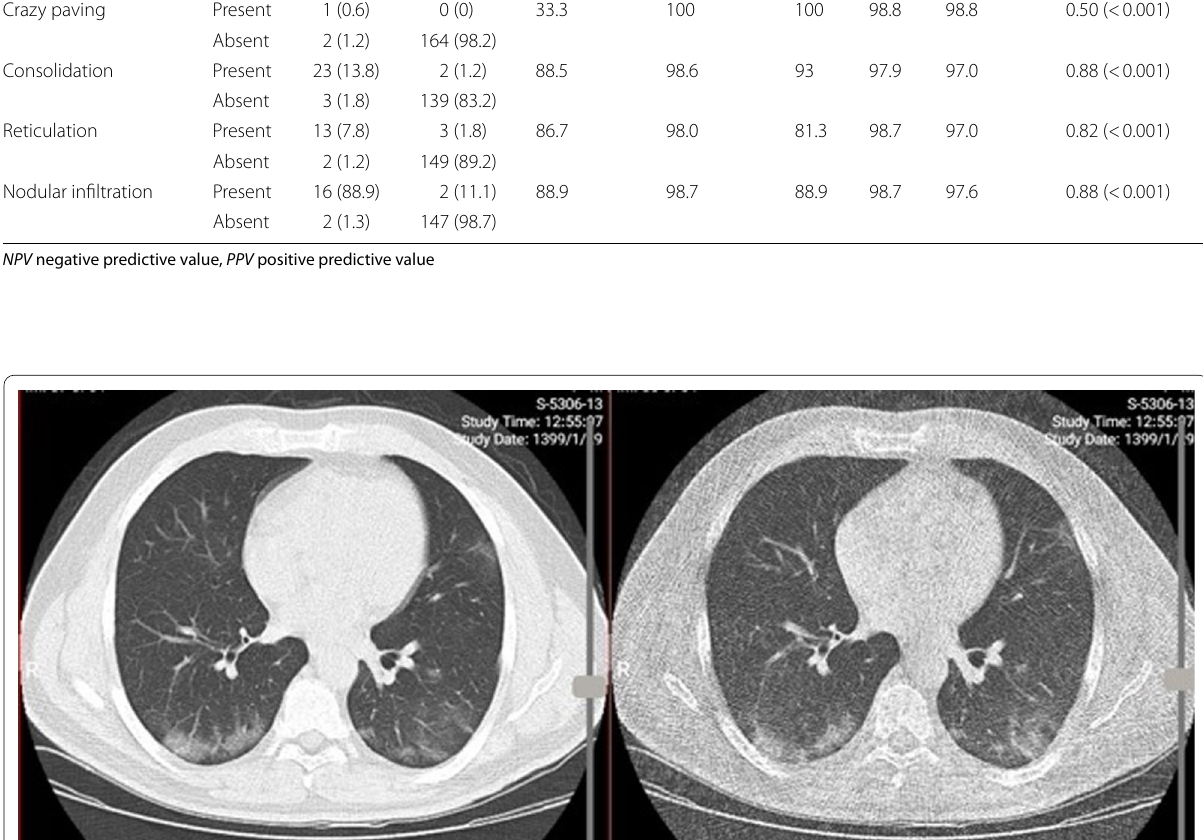
Fig. 3 Suspected reverse halo in ultra‑low‑dose images (right image) not clearly seen in low‑dose protocol (left image)